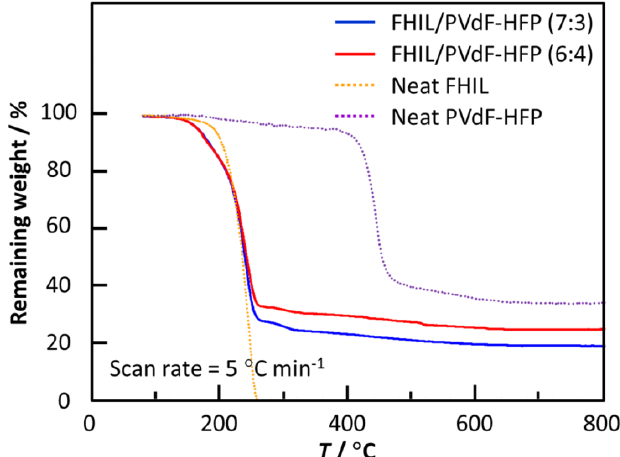
Figure 2. TG curves of EMPyr(FH) 1.7 F/PVdF-HFP (7:3 and 6:4) composite membranes, neat FHIL and neat PVdF-HFP. Scan rate: 5  C·min  1